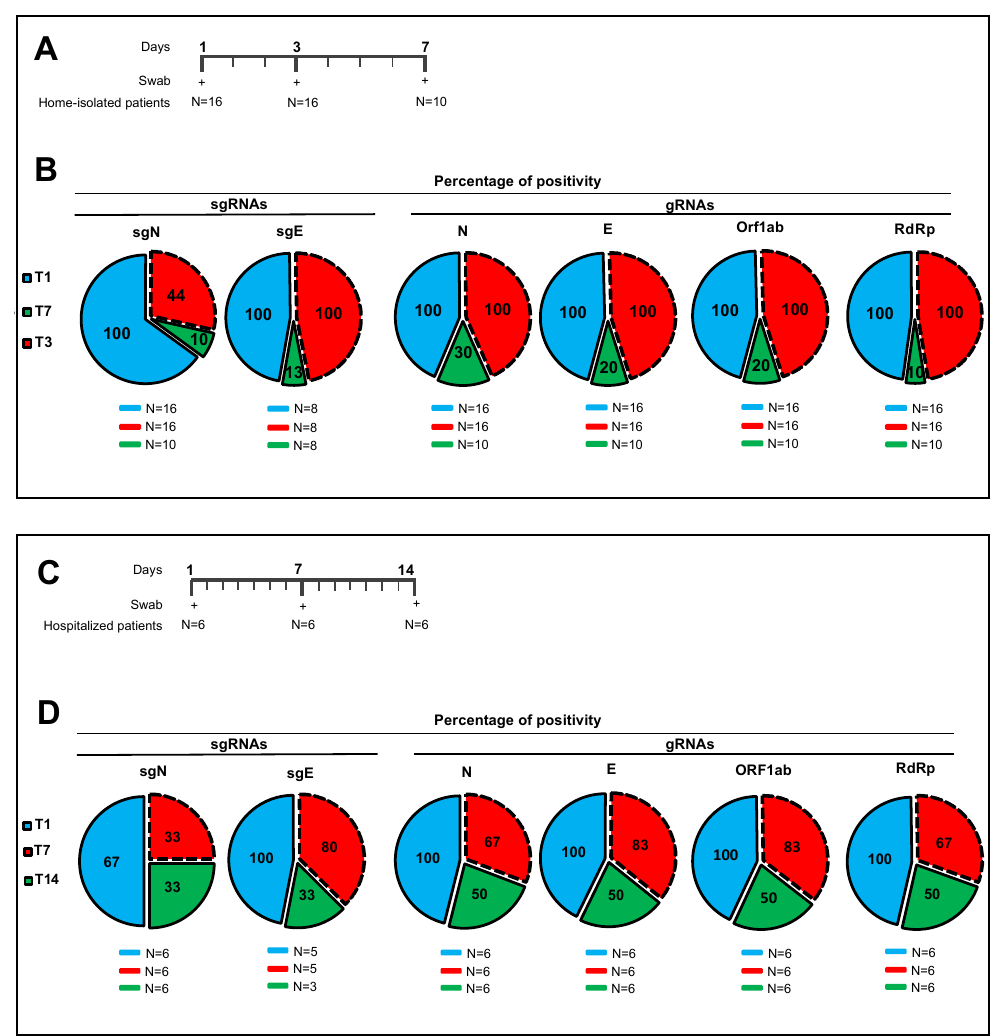
Figure 2. Loss of detection of sgN precedes SARS-CoV-2 replication failure in home-isolated and hospitalized COVID-19-affected patients. ( A ) A cohort of oro/nasopharyngeal swabs was collected from home-isolated COVID-19-positive patients and analyzed according to the scheduled times (i.e., at 3-day intervals from the first swab). Ten patients were followed up to 7 days from the first swab test; 6 patients were followed up to 3 days. ( B ) Pie charts showing the proportions (%) of positivity of the oro/nasopharyngeal samples to viral subgenomic sgN and sgE, and genomic N, E, ORF1ab, and RdRp at the different times (blue, first swab [N = 16]; red, second swab collected after 3 days [N = 16]; green, third swab collected after 7 days [N = 10]). SgE was detected in 8 oro/nasopharyngeal samples. SgN was detected in 44% of the samples after 3 days from the first swab. SgN, gene E, and gene ORF1ab were measured using the SARS-CoV-2 Viral3 kit. Gene N, gene E, and gene ORF1ab were detected using the Allplex 2019-nCoV assay. SgE was evaluated by Taqman qPCR. ( C ) A cohort of oro/nasopharyngeal swabs collected from 6 hospitalized COVID-19-positive patients was analyzed according to the scheduled times (i.e., 7-day intervals from the first swab). ( D ) Pie charts showing the proportions (%) of positivity of the oro/nasopharyngeal samples to viral subgenomic sgN and sgE, and genomic N, E, ORF1ab, and RdRp at the different time points (blue, first swab [N = 6]; red, second swab collected after 7 days [N = 6]; green, third swabs collected after 14 days [N = 6]). SgE was detected in 5 oro/nasopharyngeal samples. SgN was detected in 50% of the samples after 7 days from the first swab. sgN, gene E, and gene ORF1ab were measured using the SARS-CoV-2 Viral3 kit. N and ORF1ab were detected using the Allplex 2019-nCoV assay. SgE was evaluated by Taqman